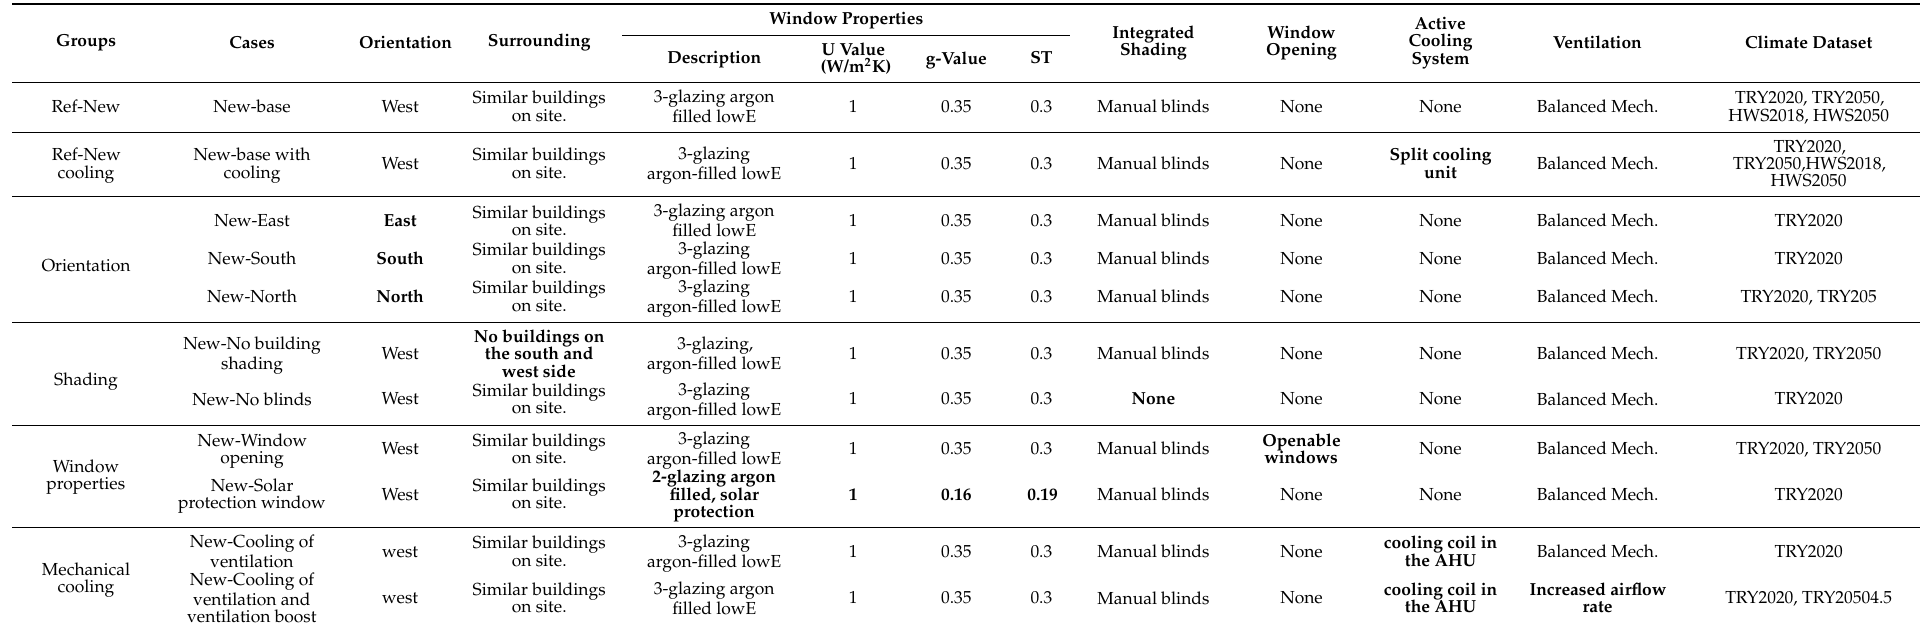
Table 4. Description of simulation cases in the new